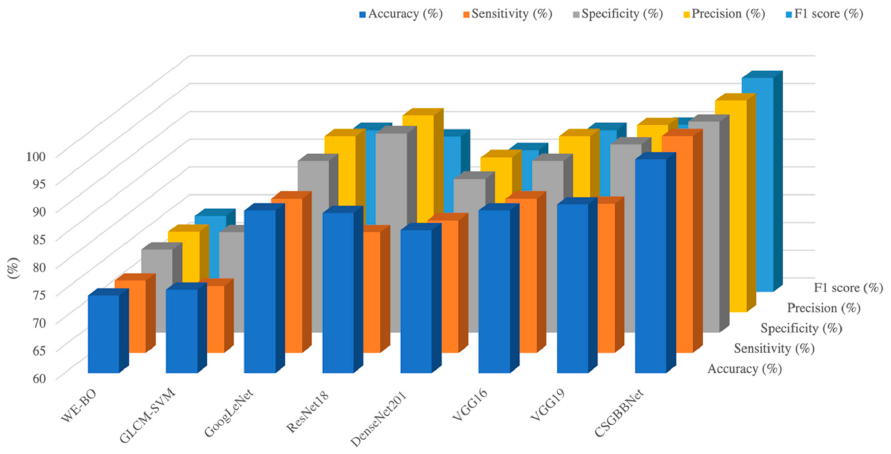
Figure 16. A summary of comparisons between state-of-art models and ours.